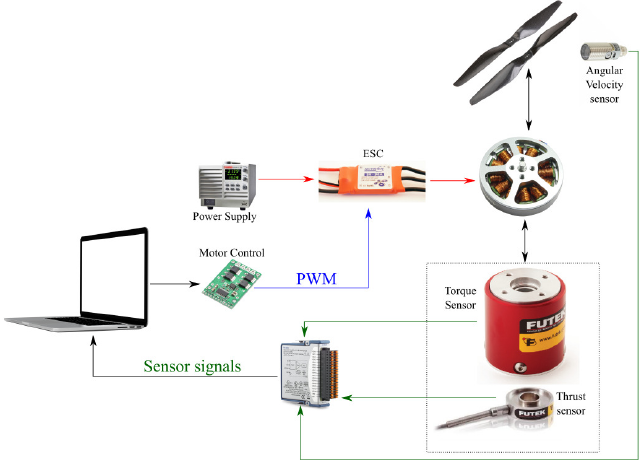
Figure 1. Experimental setup